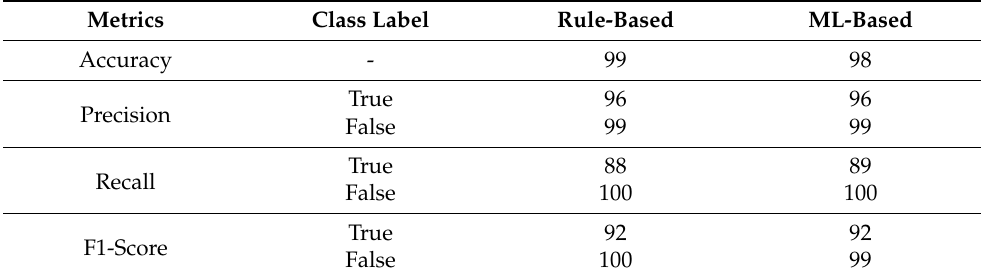
Table 4. Performance of rule-based versus machine learning-based text classification